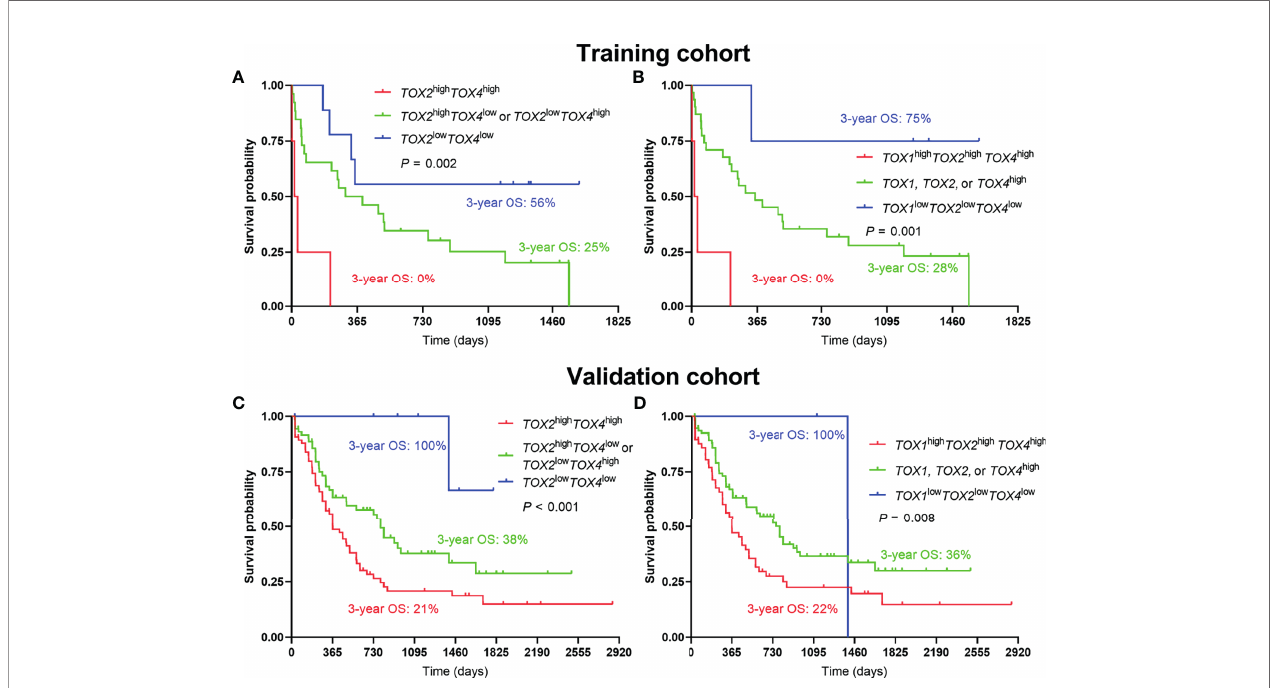
FIGURE 4 | Co-expression of TOX genes in predicting poor OS of AML patients. Kaplan-Meier curves are shown for co-high expression, single high expression, and co-low expression of TOX2 / TOX4 (A) and TOX / TOX2 / TOX4 (B) in training and validation cohort (C, D)